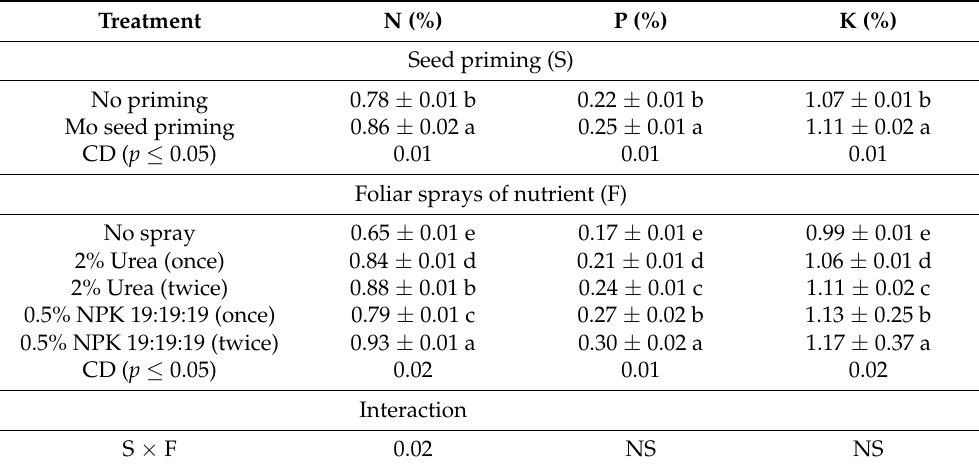
Table 8. Effect of seed priming and foliar sprays on leaf nutrients (N, P and K) content (%) in grass pea (pooled means of 2